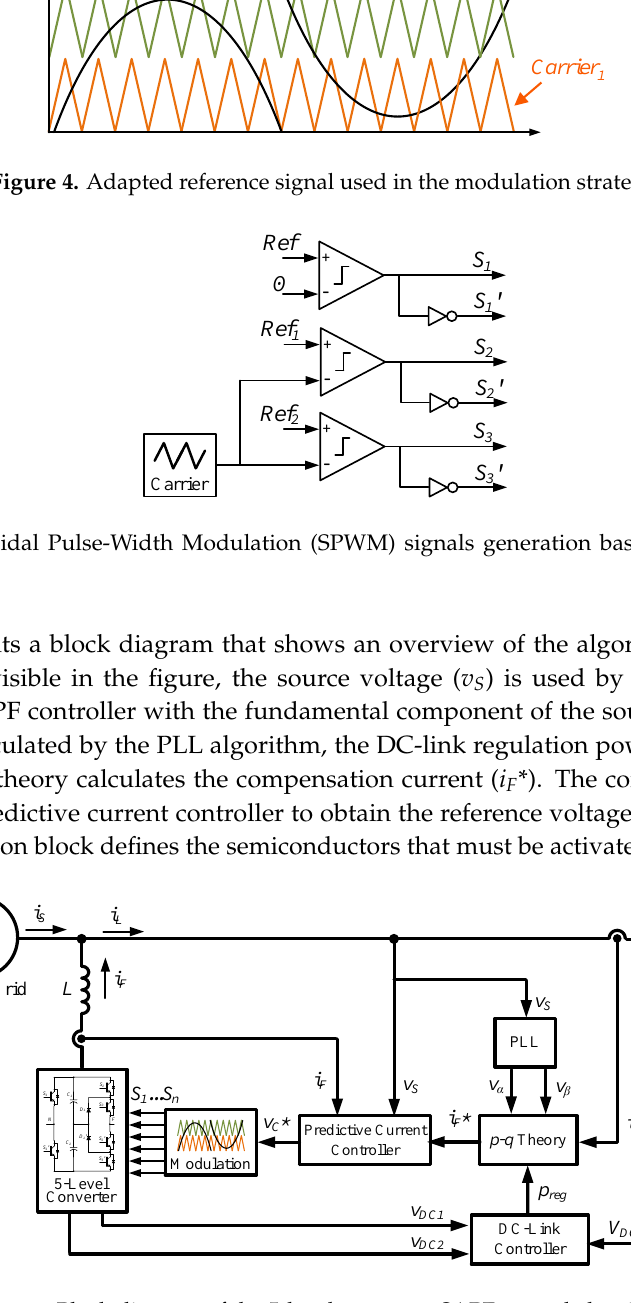
Figure 6. Block diagram of the 5-level converter SAPF control algorithms.